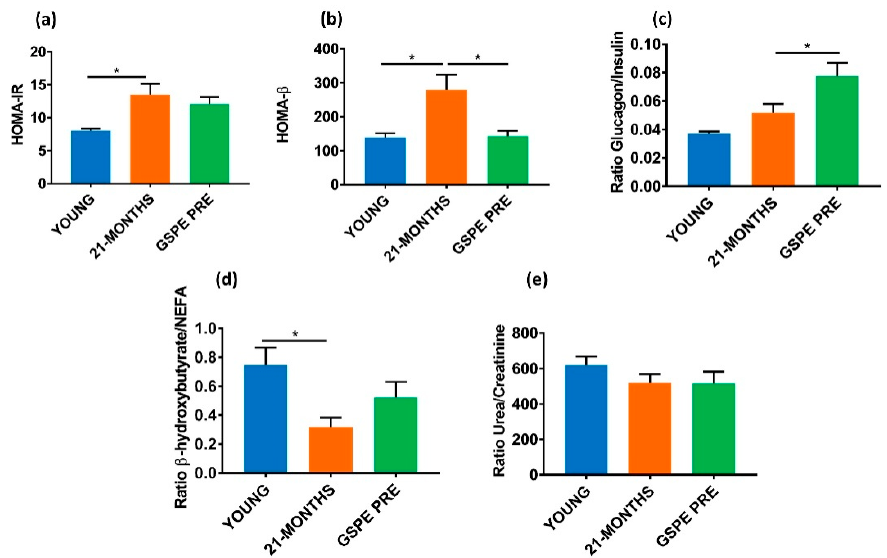
Figure4. Biochemicalcharacteristicsofthegroupsanalyzedat13weeks. ( a )InsulinresistanceHOMA-IR Figure 4. Biochemical characteristics of the groups analyzed at 13 weeks. ( a ) Insulin resistance index. ( b ) Insulin resistance HOMA- β index. ( c ) Glucagon / insulin ratio. ( d ) β -hydroxybutyrate / non- HOMA-IR index. ( b ) Insulin resistance HOMA- β index. ( c ) Glucagon/insulin ratio. ( d ) esterified fatty acids (NEFA) ratio. ( e ) Urea / creatinine ratio. Values are means ± SEM. * p < 0.05 compared β -hydroxybutyrate/non-esterified fatty acids (NEFA) ratio. ( e ) Urea/creatinine ratio. Values are with 21-MONTHS rats. means ± SEM. * p < 0.05 compared with 21-MONTHS rats.